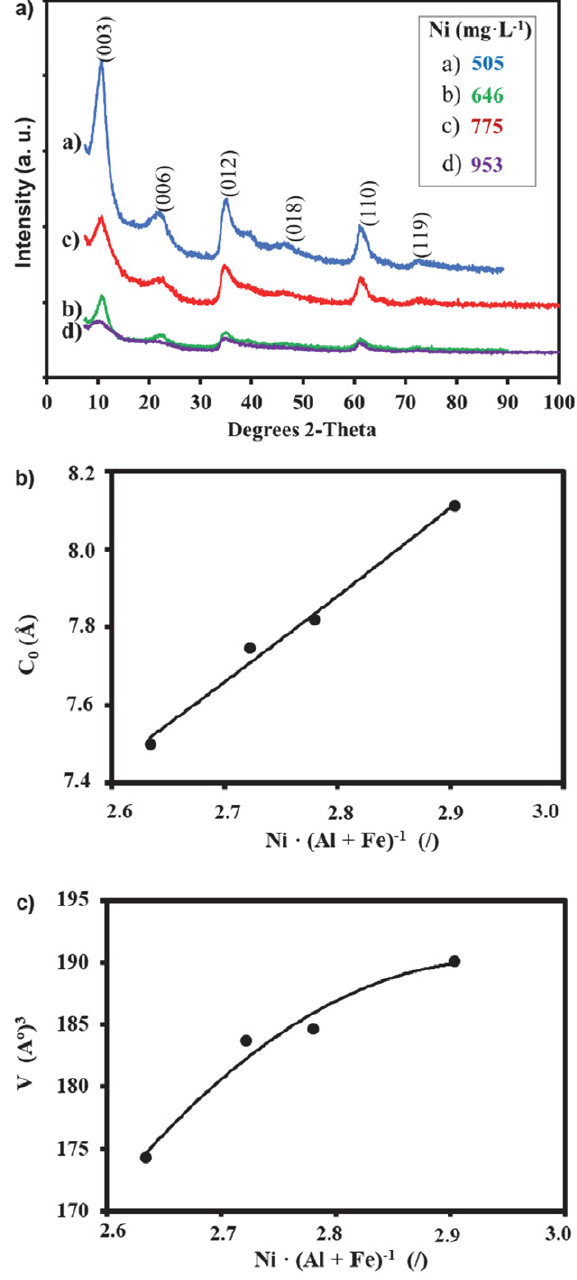
Figure 5 . FTIR spectral of Ni/Al-LDH from different nickel concen- tration, a) 505 mg L –1 , b) 646 mg L –1 , c) 775 mg L –1 , d) 953 mg L –1 From the DXR analysis, the spacing (d hkl ) of the LDHs, the crystal lattice parameters (a, c) and the crys- tallite size (D hkl ) were determined (Table 7).